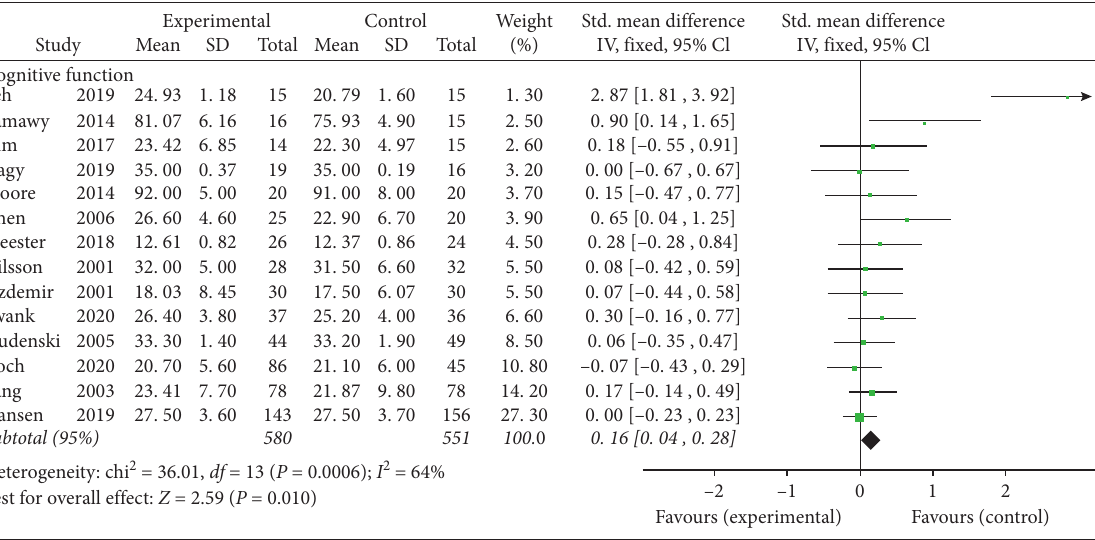
Figure 3: Meta-analysis on the cognitive benefit of exercise.